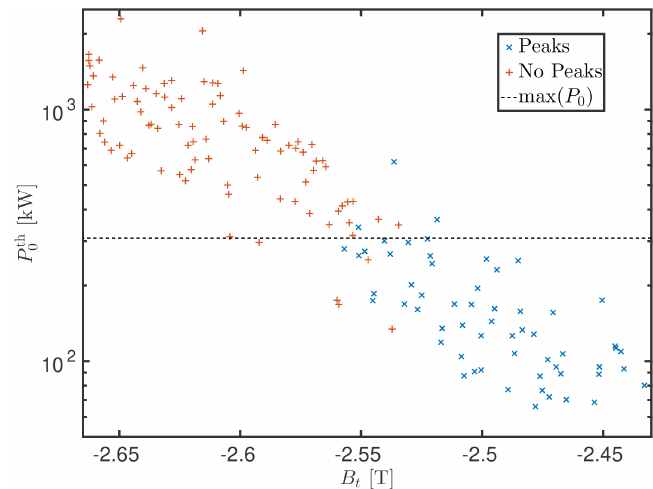
Figure 4. The development of P th during the B t -scan in ASDEX Upgrade discharge #34575, calculated using the theory of [8]. The 0 pulses for which peaks are observed in the PDI frequency range (cf. Figure 2) are marked by × , while the pulses for which no such peaks are observed are marked by + ; max( P 0 ) = 308kW is marked by the dashed line. Evidently, the occurrence of PDI peaks is < max( P 0 ) provided by the theory of closely correlated with fulfilment of the condition P th 0